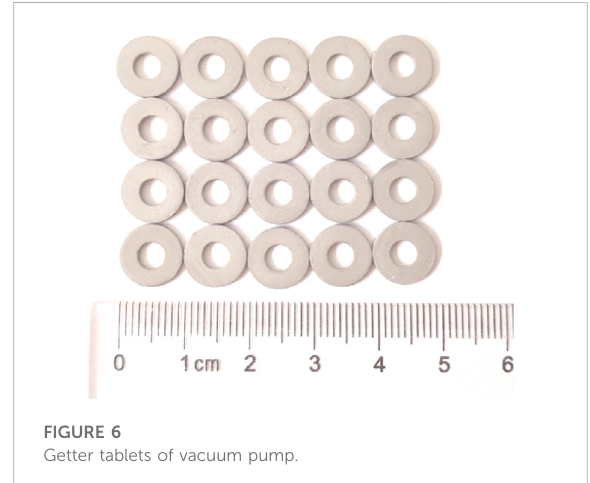
FIGURE 6 Getter tablets of vacuum